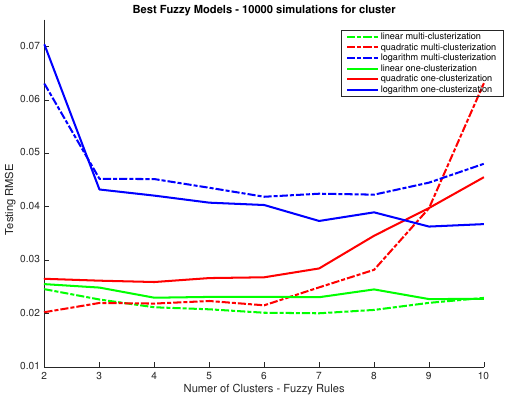
Figure 4. RMSE between predictions from the Fuzzy Logic Inference System (FIS) and desired outputs in the CIEXYZ training dataset (y axis) vs. number of clusters used (x axis). Legend indicates for each plot if the same input clusterization is used for all outputs or not.